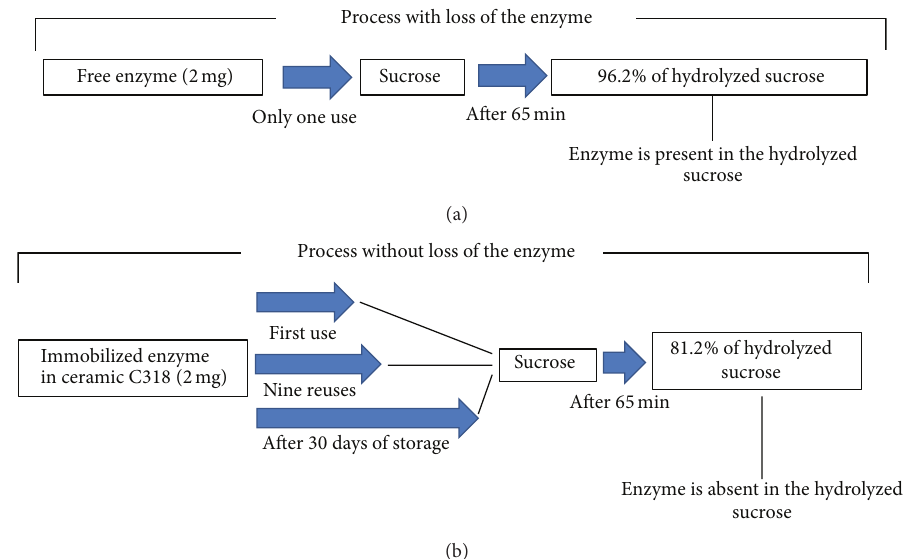
Figure 6: Schematic representation of the results from hydrolysis experiments: (a) free enzyme and (b) immobilized enzyme in